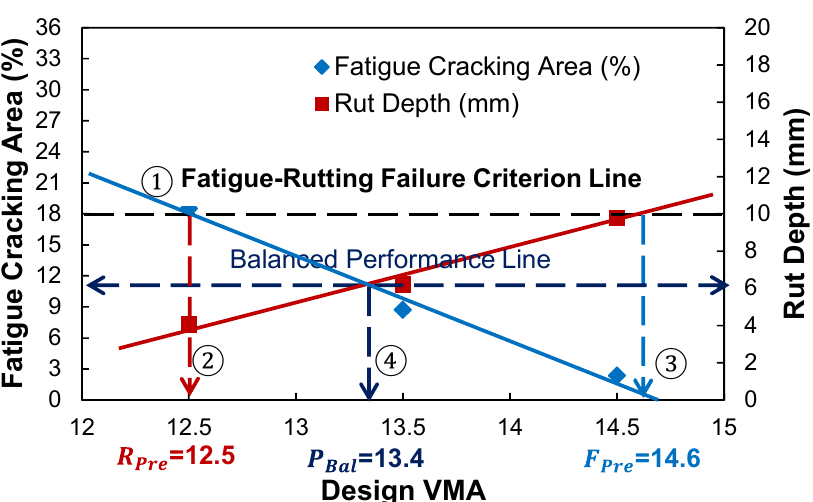
Figure 2. Analytical procedure to determine the performance targets and their volumetric AQC targets of three PBMD categories using the failure criterion and balanced performance lines.